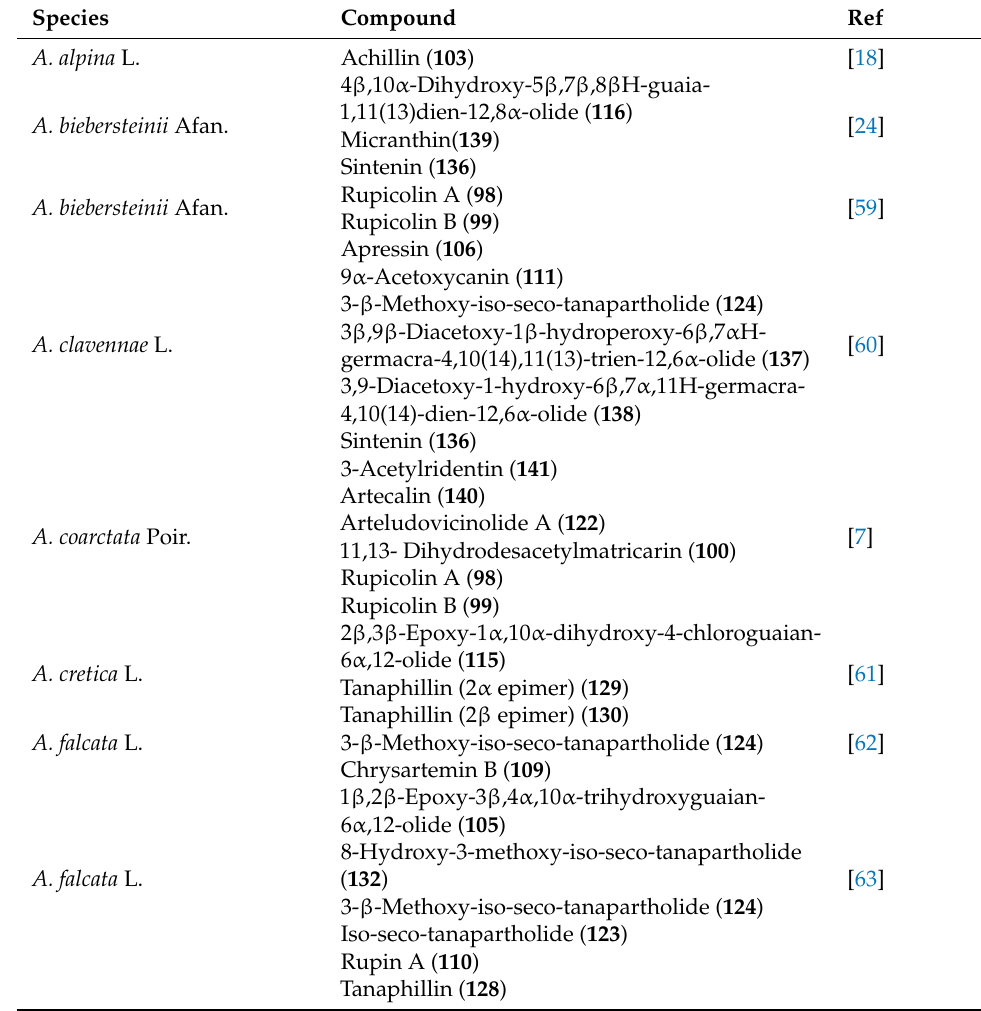
Table 7. Sesquitepene lactones from Achillea spp. Species